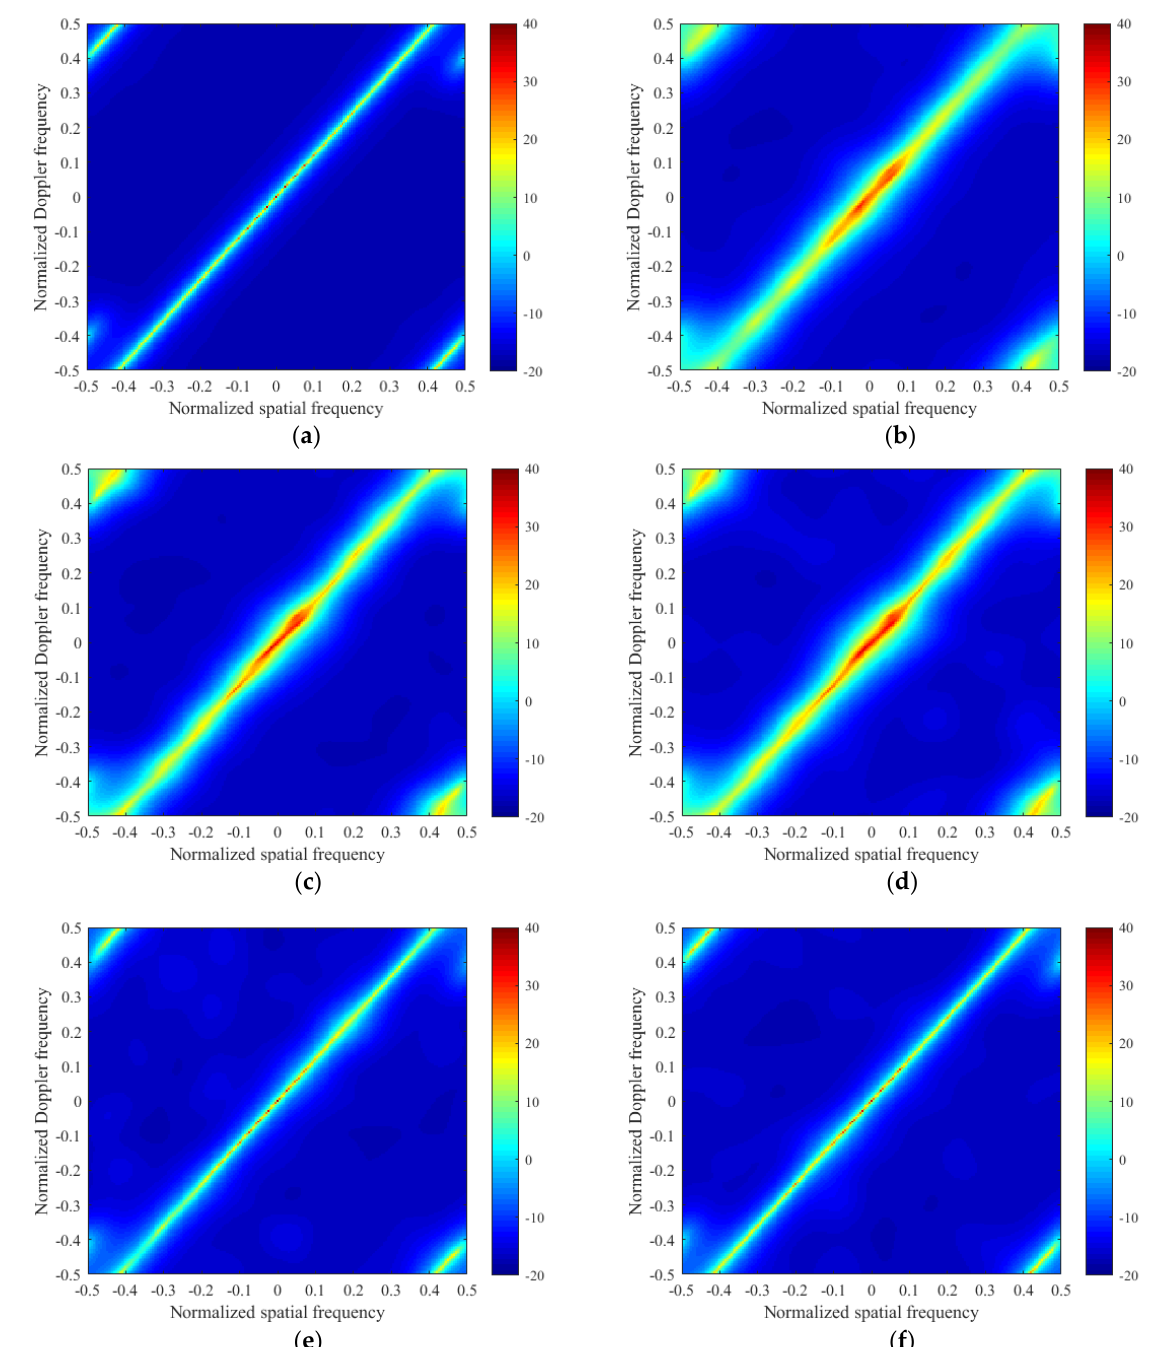
Figure 3. Comparison between the clutter angle-Doppler spectrum estimated by different algorithms